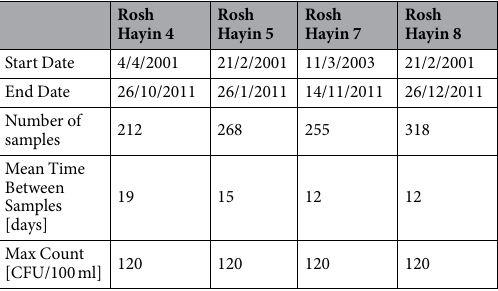
Table 1. Rosh Hayin wells sampling information.